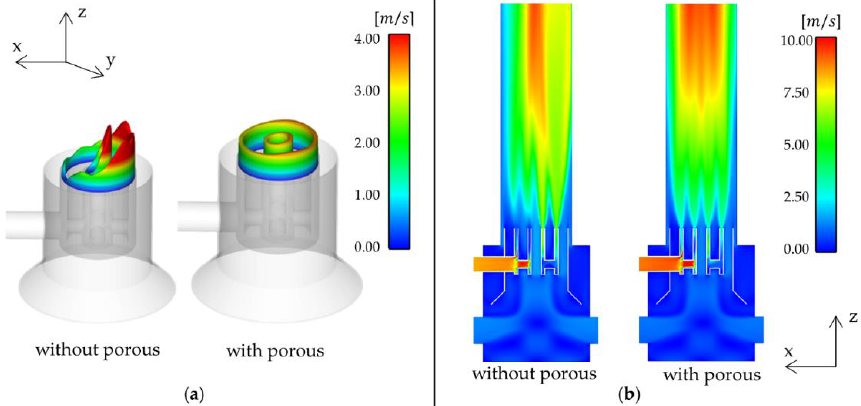
Figure 7. Effect of a flame arrestor on the velocity distribution: ( a ) isoview, ( b ) axial plane.